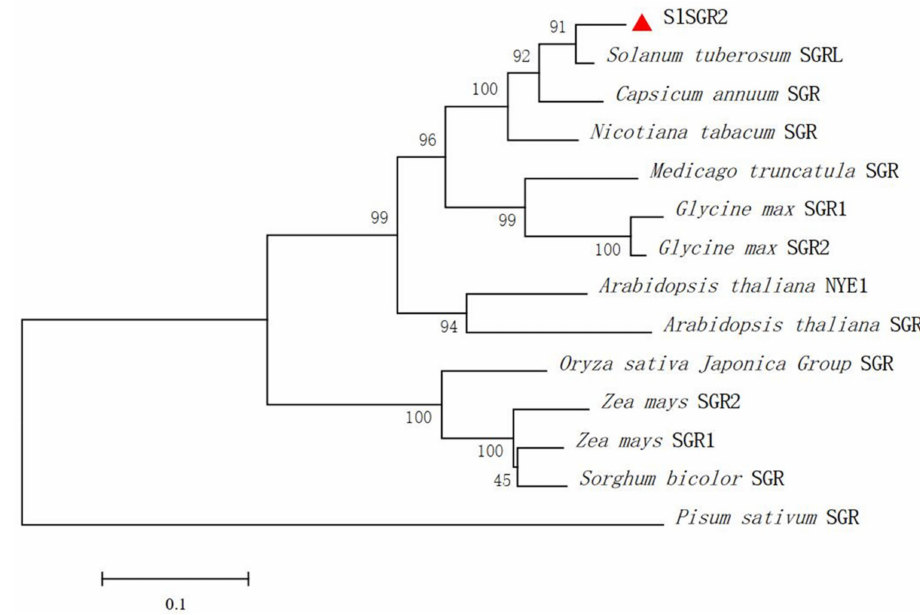
Figure 4. Phylogenetic tree of SlSGR2 proteins.